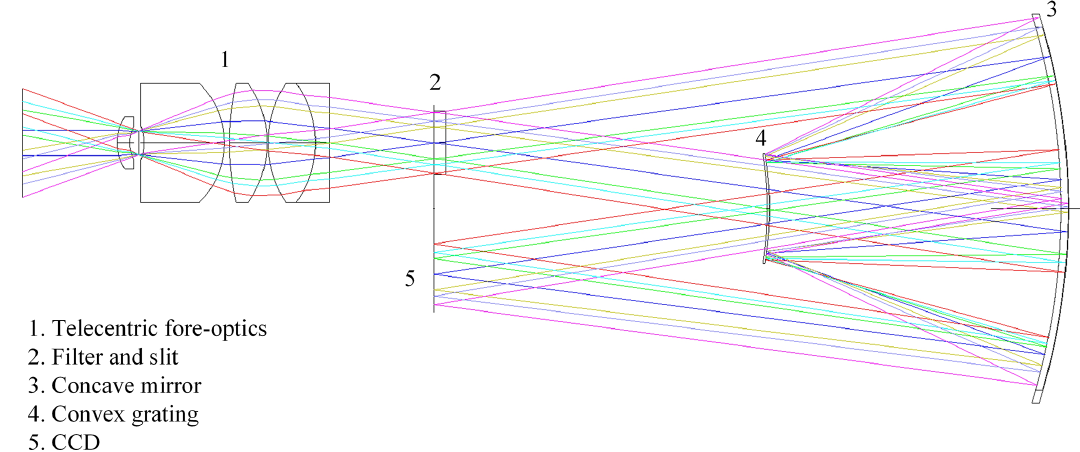
Figure 1. Optical layout of UVHIS channel 3. The optical design of channel 1 and channel 2 is similar.